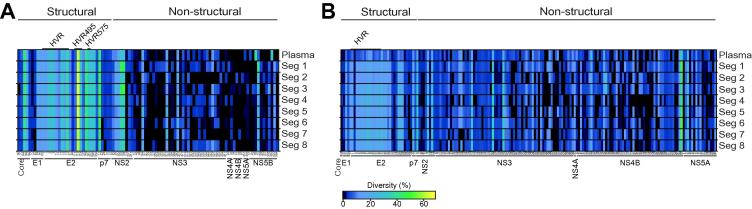
Deep sequencing of HCV hepatic and plasma quasispecies. Linear heat map representation of amino acid diversity within the structural and non-structural proteins for the plasma and for the 8 segment biopsies from patient 1 (A) and patient 2 (B). Each square represents a polymorphic codon, coloured to reflect the percentage of reads that exhibit diversity. The diversity scale is colour coded with highly conserved residues in black. Low frequency polymorphisms (<10%) are in dark blue, intermediate levels of polymorphism shade from blue (10%) to green (45%), with the most highly variant residues (45–60%) shaded from green to orange. Only codons exhibiting diversity greater than 1% are shown.